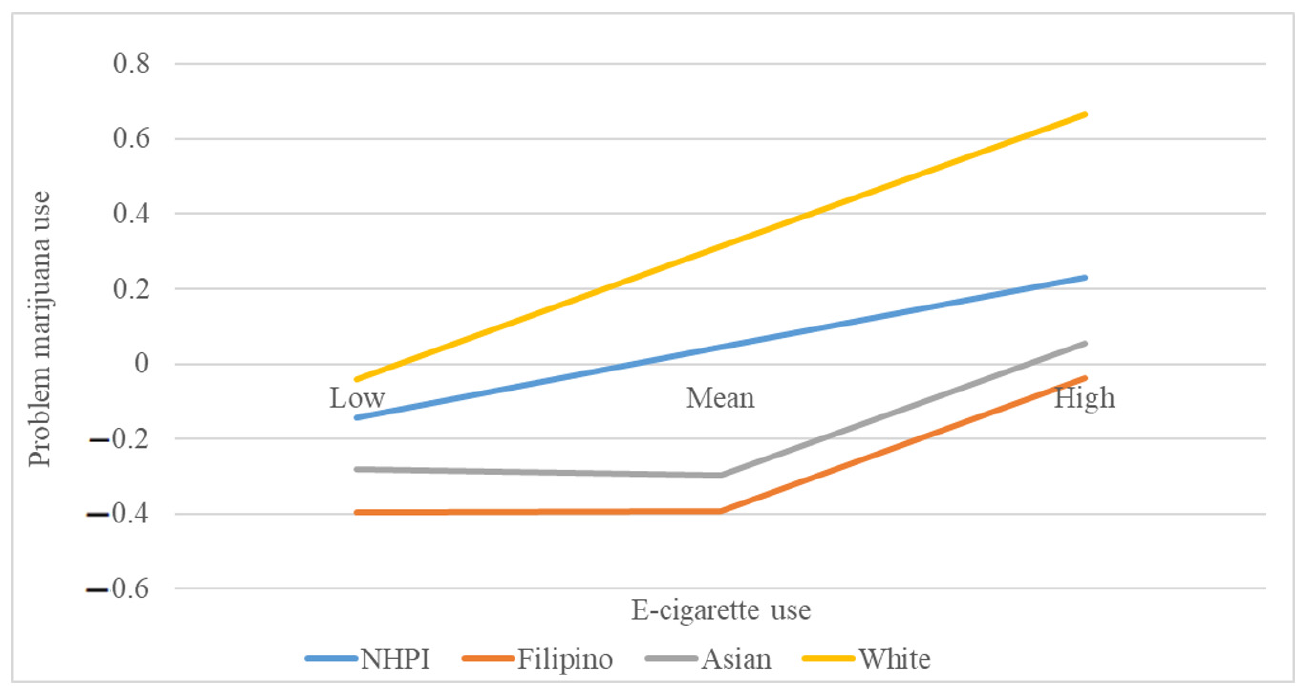
Figure 2. Relationship between baseline e-cigarette use and future problem marijuana use as moderated by ethnicity. (NHPI: Native Hawaiian and other Pacific Islander. Low, Mean, and High denote levels of e-cigarette use at mean, one standard deviation unit lower than the mean (low), and one standard deviation higher than the mean (high)).